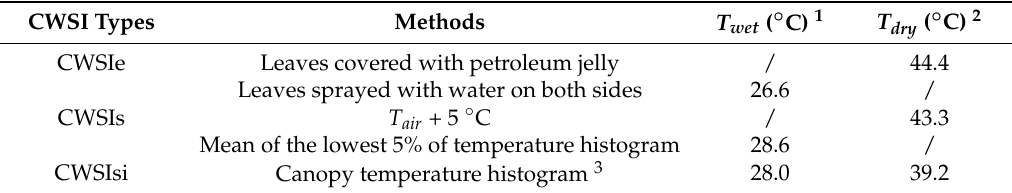
Figure 4. ( a ) Histogram (canopy and soil pixels) of temperatures of the entire experimental plot; ( b ) Histogram (cotton canopy pixels) of canopy temperatures of the entire experimental plot. Note: the white lines of histogram represent null temperature values. Table 2. Different methods of T wet and T dry